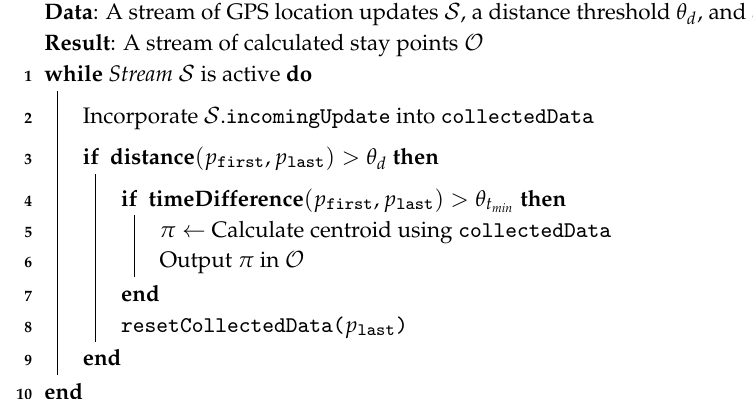
Algorithm 2: A generic event-driven adaptation of Li’s algorithm for conducting on-line stay points